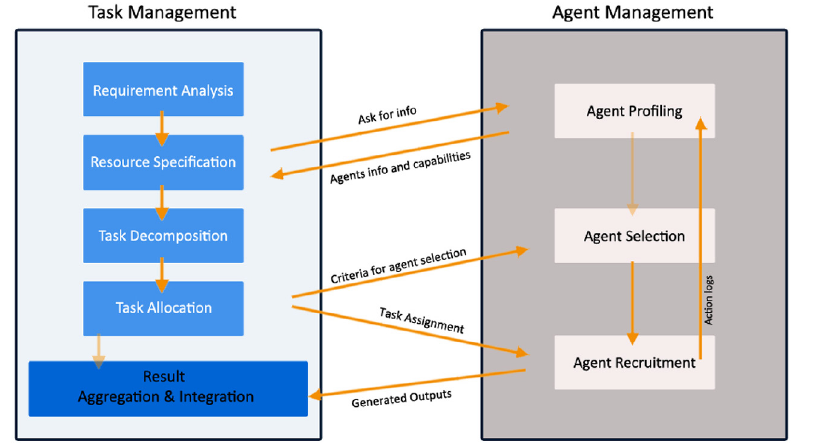
Figure 7. General internal